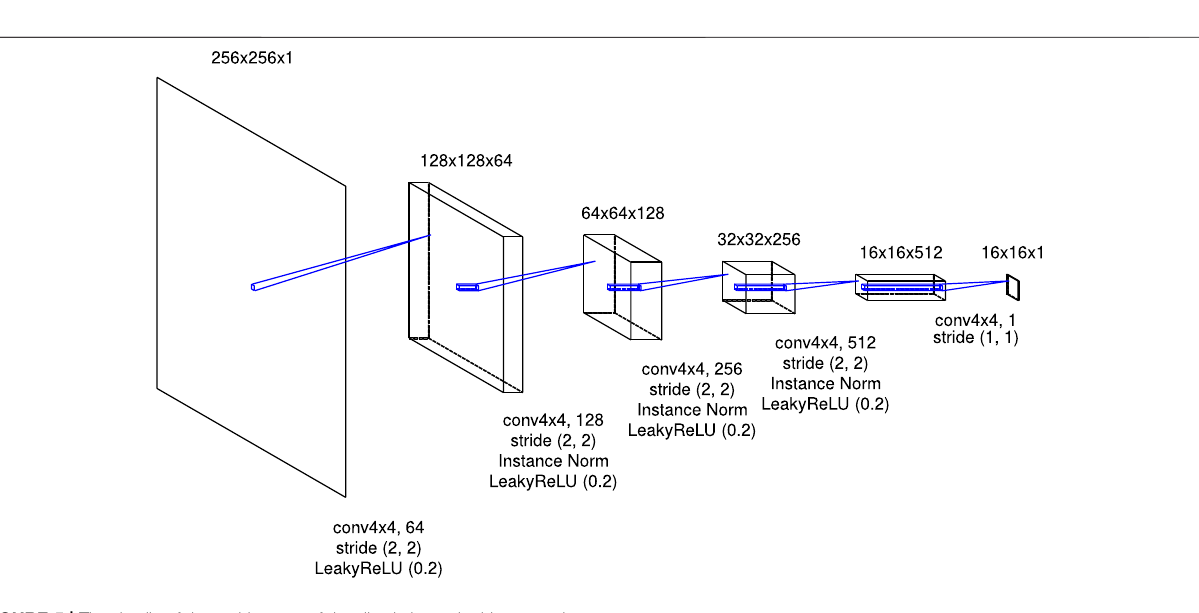
FIGURE 5 | The details of the architecture of the discriminator in this